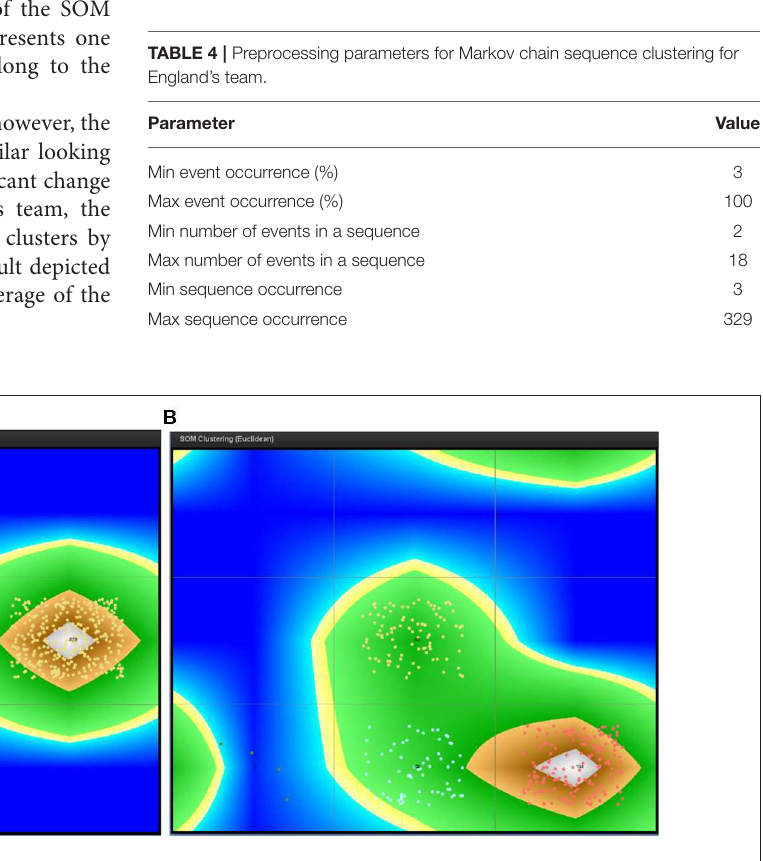
Frontiers in Artificial Intelligence |